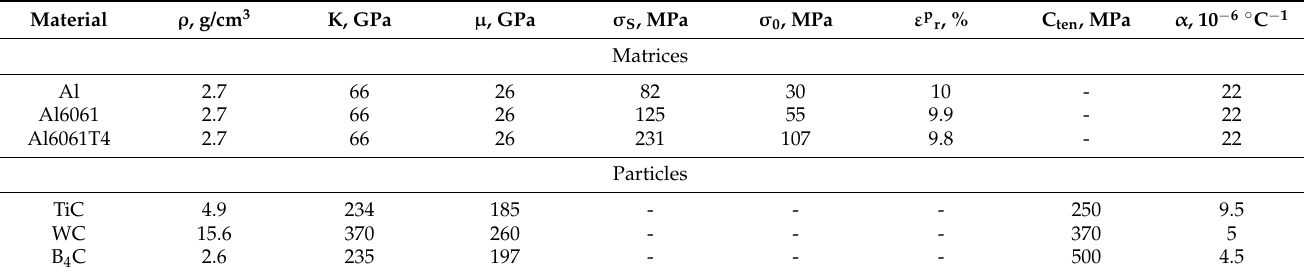
Table 1. Thermomechanical properties of the matrix and particle